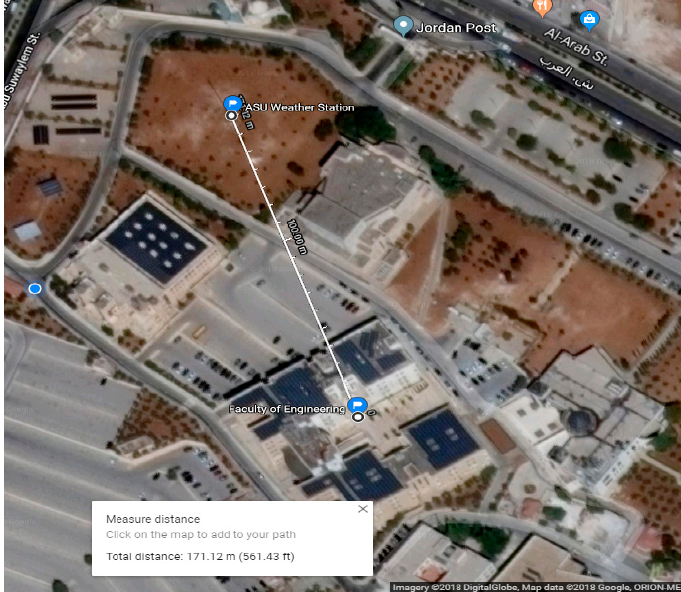
Figure 4. Weather station and PV system at ASU (retrieved and adapted from Google Maps [37]).